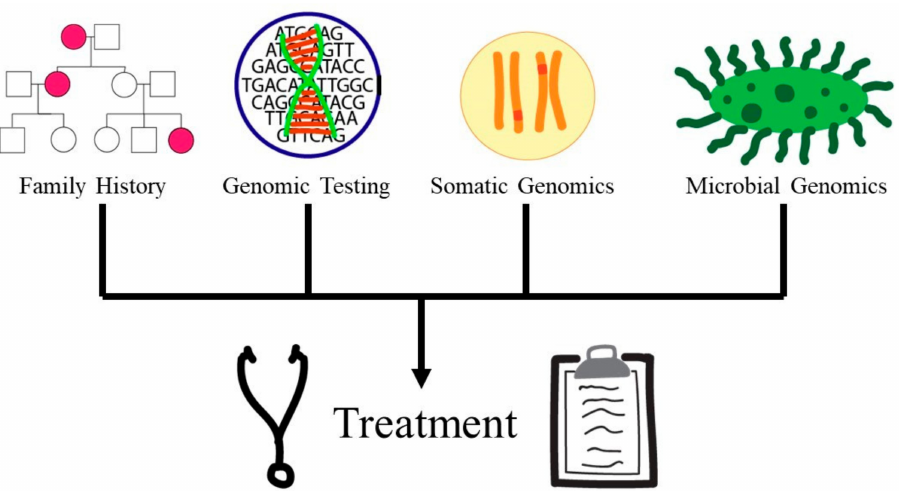
Figure 4. Five “entrustable professional activities” or EPAs necessary for physician instrumentation of genomics in the medical field and areas of focus for analyzing physician genomic competency adapted from [93]. These EPAs include family history, genomic testing, somatic genomics, and microbial genomics which all play a vital role in improving patient